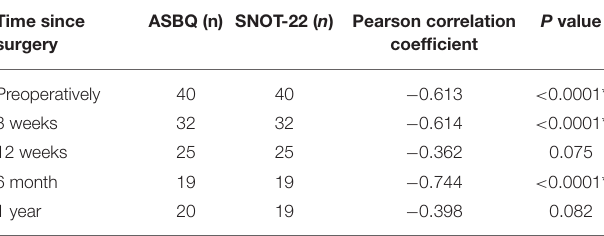
TABLE 4 | Correlation between SNOT-22 and ASBQ scores.